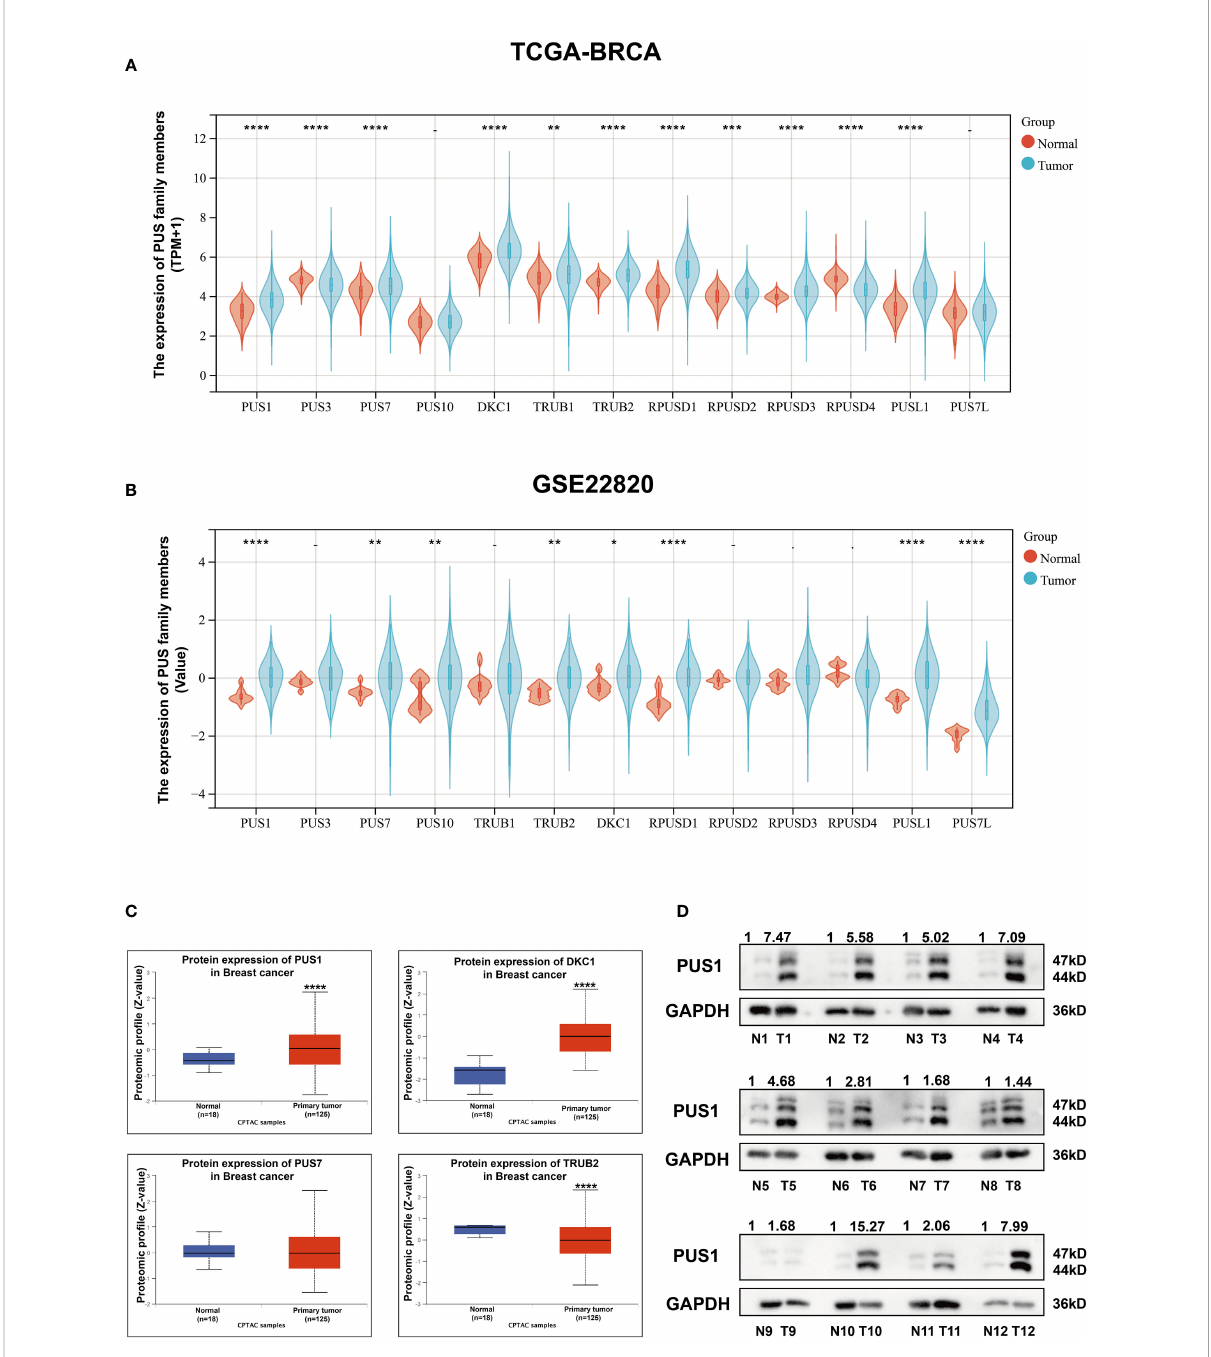
FIGURE 1 There was higher expression of PUS1 mRNA and protein in breast cancer tissues than in normal tissues. (A, B) ; The mRNA expression values for individual members of the pseudouridylate synthase family in TCGA and GEO22820 datasets are plotted in violins. Red violins represent normal tissues and green violins tumor tissues.; (C) The proteomic results of the four pseudouridylate synthases are displayed as z-values based on the CPTAC breast cancer dataset generated by UALCAN database. Blue, normal tissue. Red, primary tumors. The median Z values of PUS1 and DKC1 in primary tumors were substantially greater than those in normal tissues while the median of TRUB2 was lower in tumor tissues than in healthy tissues. No signi fi cant difference of PUS7 was observed between the tumor and normal groups. (D) The protein expression of PUS1 in 12 paired breast cancer tissues and normal tissues validated by western blotting assay. The relative intensity of bands was fi rst measured and quali fi ed by ImageJ, and then normalized to GAPDH. Detection of PUS1 revealed two bands with approximately molecular masses of 44 and 47 kDa and most tumor tissues showed higher levels of PUS1 than their corresponding normal tissues. *, P value < 0.05; **, P value < 0.01; *** or more, P value <